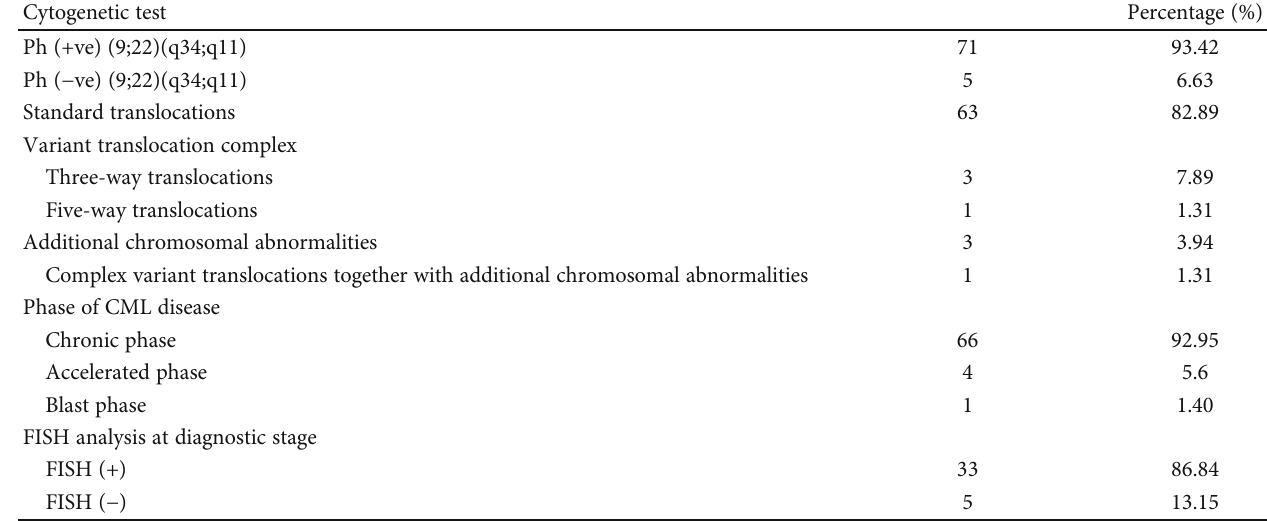
Table 3: Cytogenetic results of CML patients, phases at the time of diagnosis ( N = 71 ), and FISH analysis ( N = 38 ). Cytogenetic